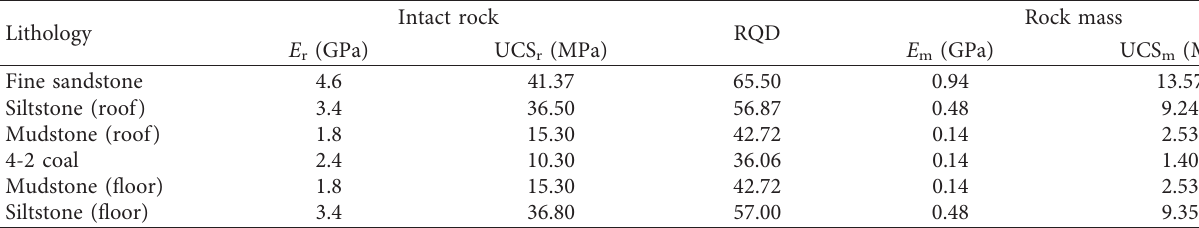
Table 1: Calculated macrostrength parameters of intact rock and rock mass.